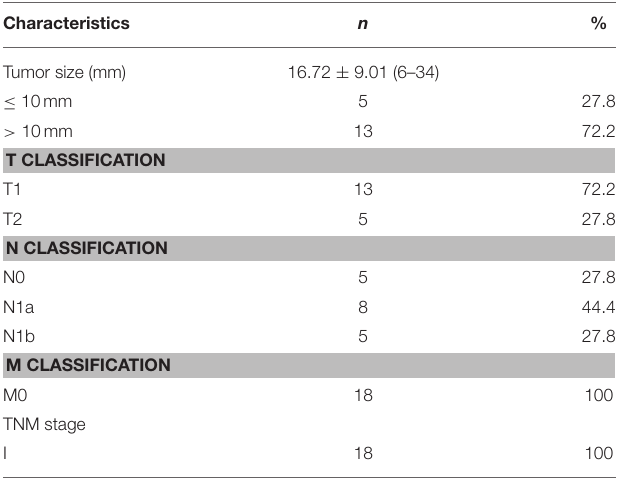
TABLE 3 | Pathological characteristics according to eighth edition of AJCC/TNM classification system.